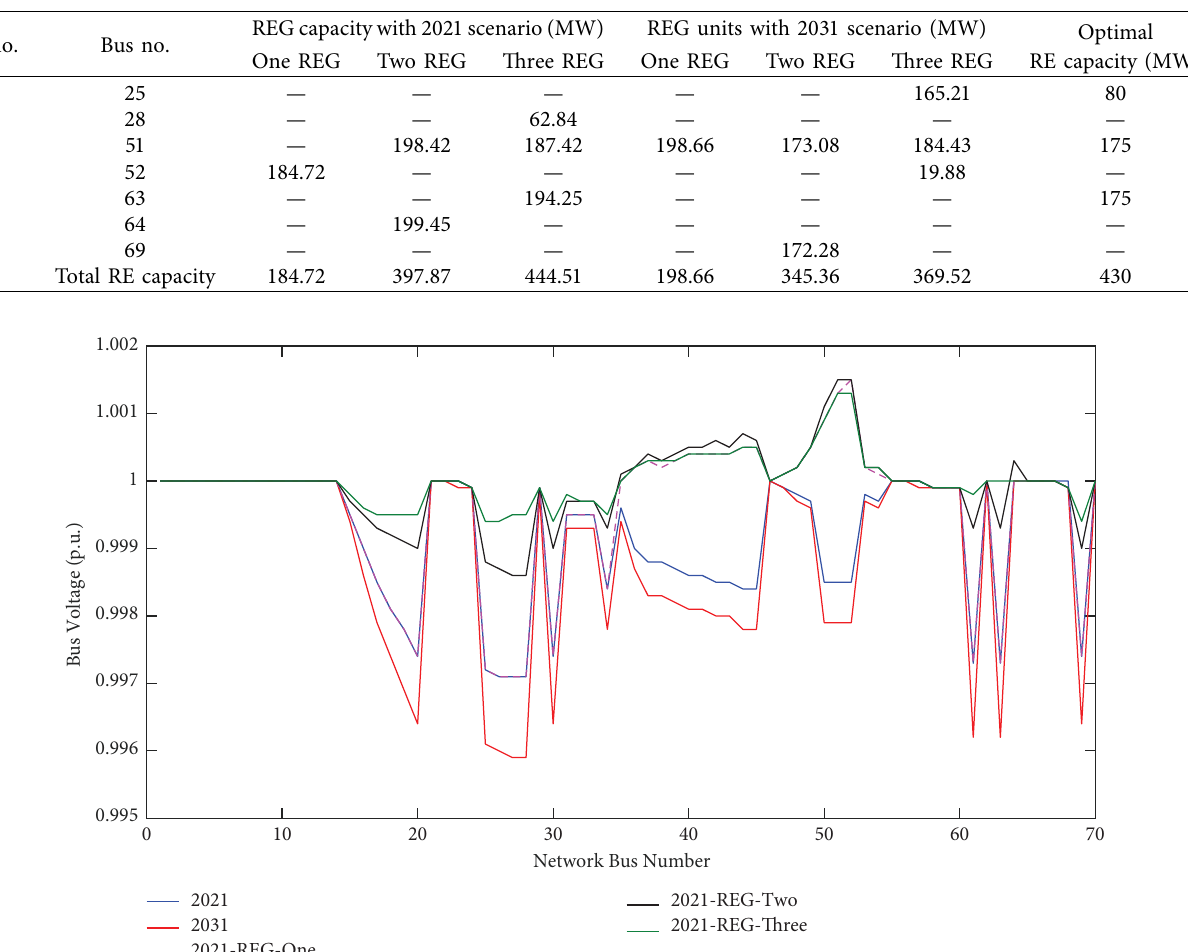
Table 12: Optimal capacity of RE generators.